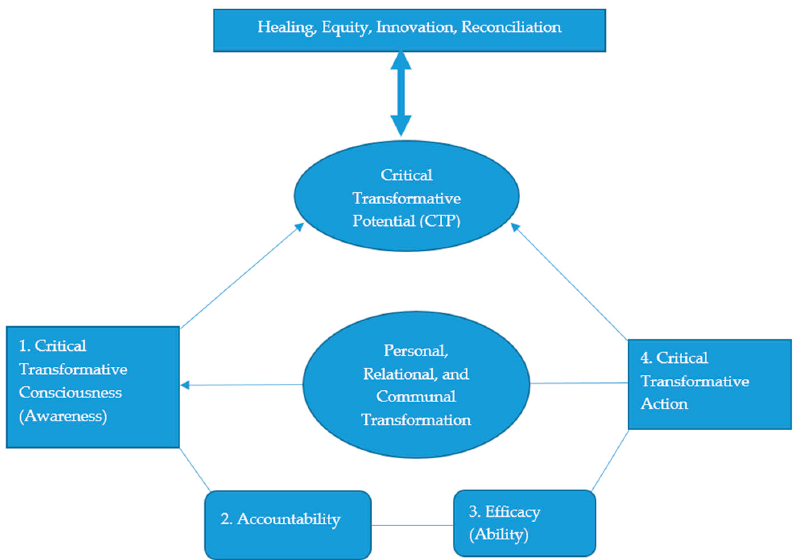
Figure 4. Critical Transformative Potential Development Framework. Note. Figure 4 depicts the four pathways (numbers 1–4) of the Critical Transformative Potential Development Framework (Bussey et al. 2020). Critical Transformative Potential is the proposed outcome from the process of Critical Transformative Potential Development.